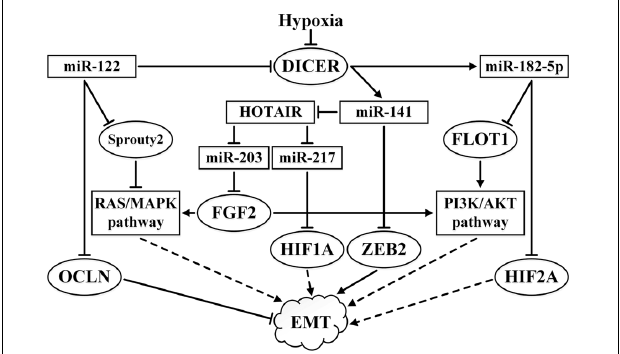
FIGURE 4 | Summary of the effects of miR-122, miR-141, miR-182-5p, miR-203, and miR-217 and their interactions with lncRNA HOTAIR on EMT-related pathways in ccRCC. ↑ indicates activity stimulation and (cid:62) indicates activity suppression according to any of the mechanisms. Solid lines indicate direct influence, while the dashed lines indicate an effect through